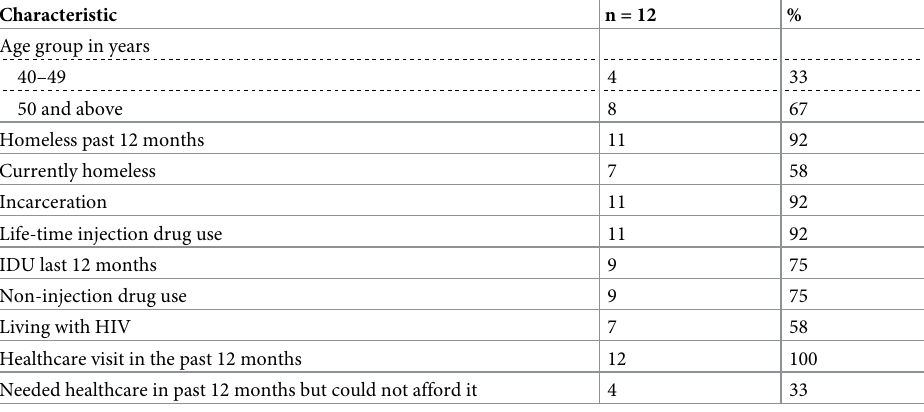
Table 3. Characteristics among trans women living with HCV viremia.